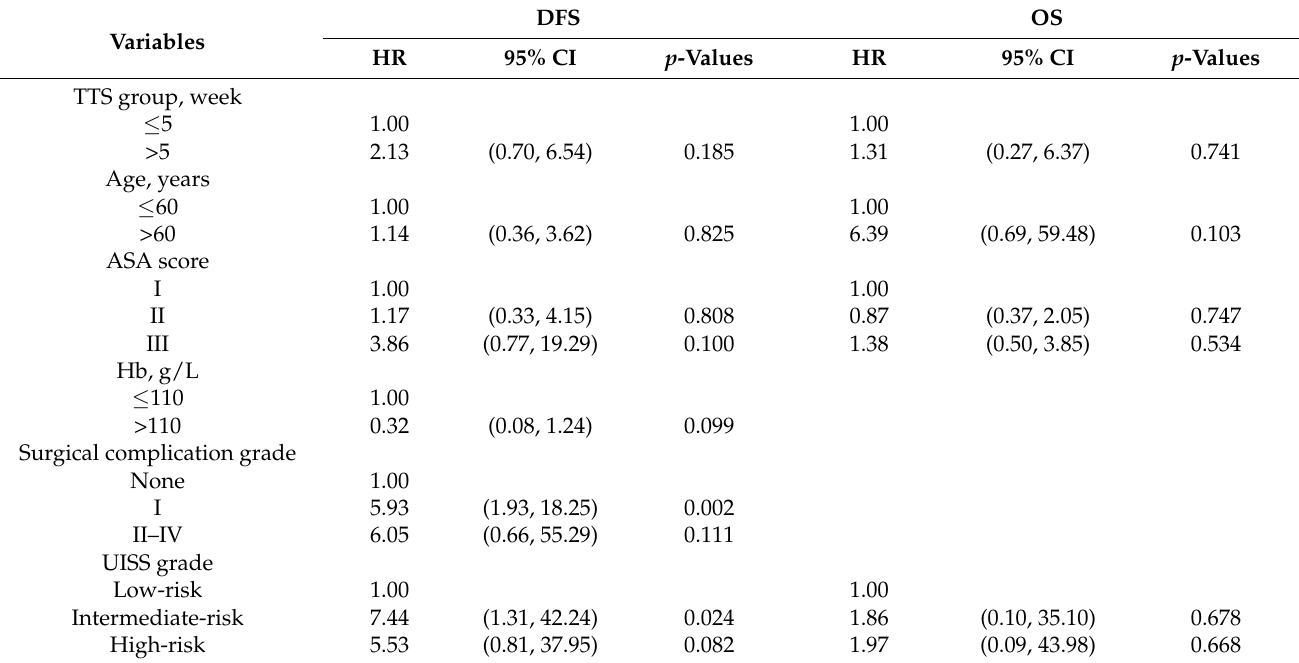
Table 3. Multivariable Cox regression for DFS and OS among T1a